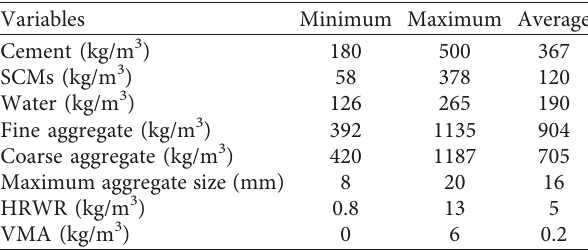
Table 1: Mix design parameters after cleaning the database.